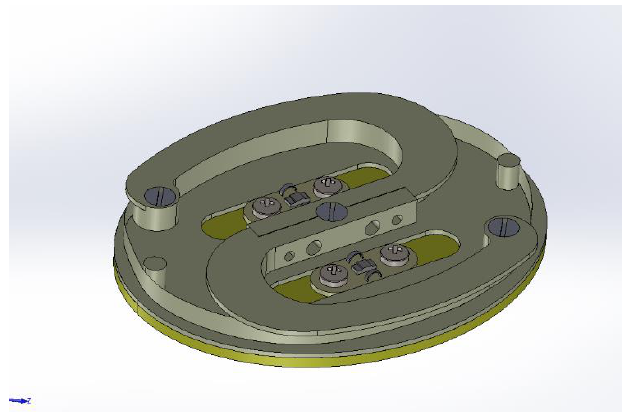
Figure 7. CAD model of the antenna deployment system .